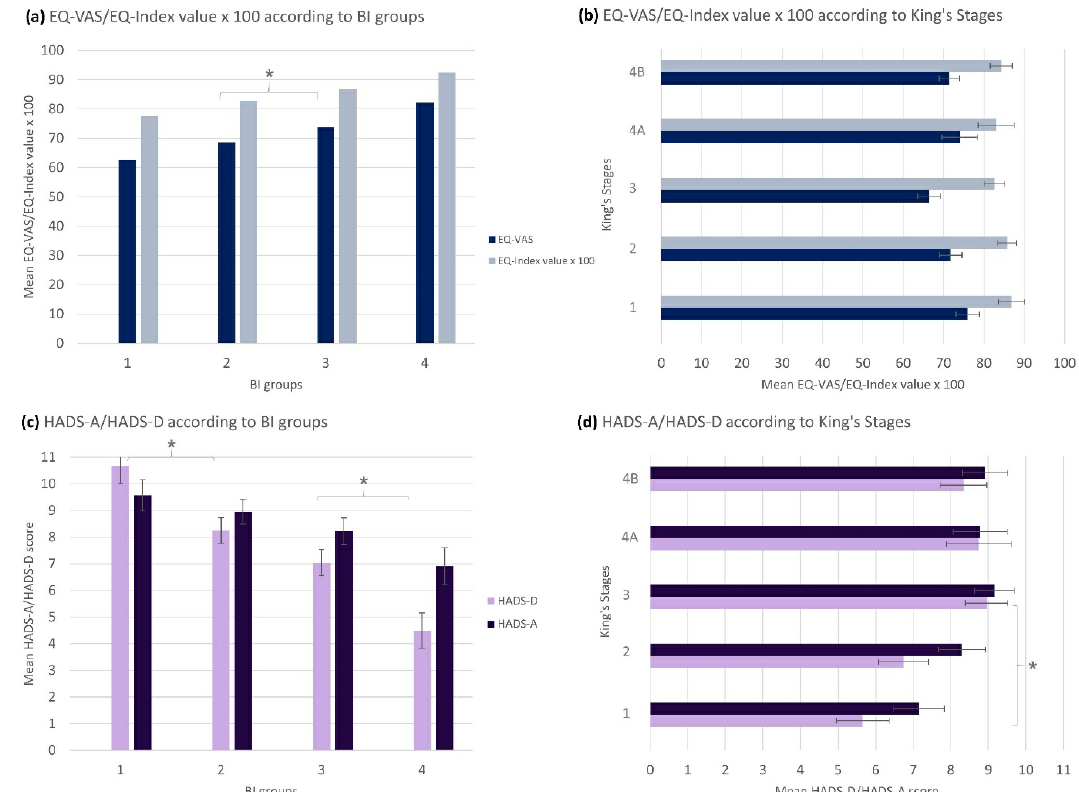
Figure 3. Caregivers’ health-related quality of life and anxiety/depression: Mean scores are presented with standard errors. Statistically significant findings: ( a ) EQ-VAS/EQ-5D-5L index value-BI groups (ANOVA: p < 0.001; KWT: p < 0.001; r s = 0.317, p < 0.001, n = 243/ANOVA: p = 0.005; KWT: p = 0.001; r s = 0.252, p < 0.001, n = 244); EQ-VAS/EQ-5D-5L index value-BI (r p = 0.320, p < 0.001, n = 243/r p = 0.258, p < 0.001, n = 244); ( b ) EQ-VAS/EQ-5D-5L index value-King’s Stages